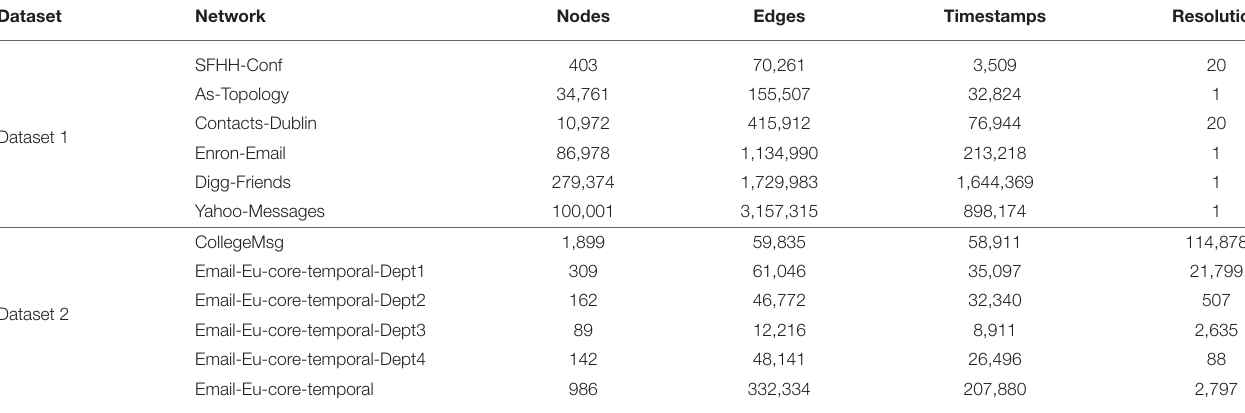
TABLE 1 | Datasets of temporal networks used for the experiments.